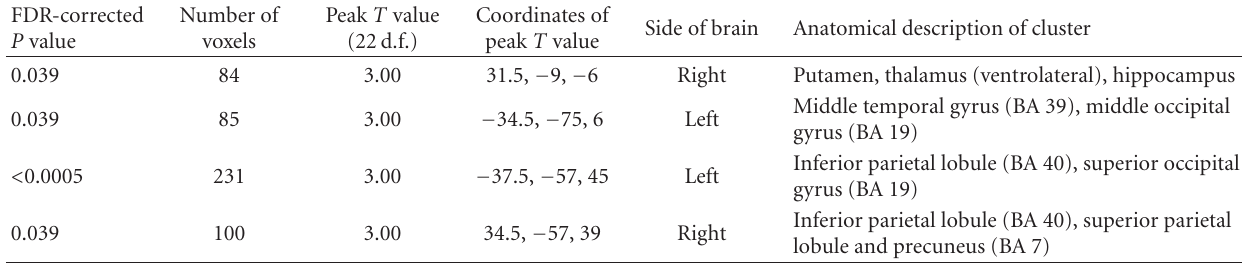
Table 4: CBF correlates with emotional